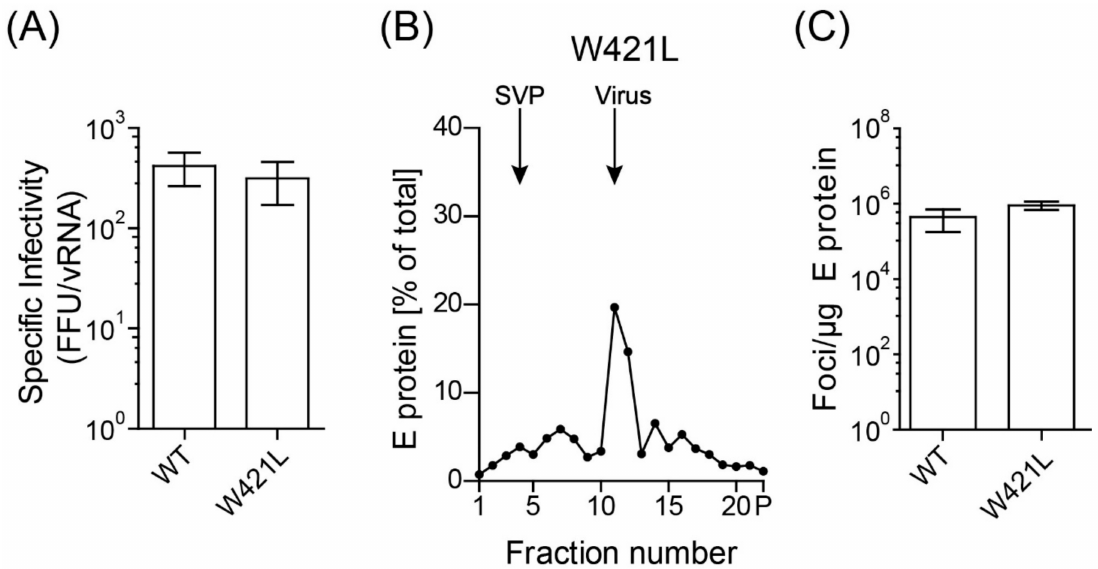
Figure 7. Infectious properties and particle state of W421L mutant. ( A ) Specific infectivities are indicated as number of focus forming units (FFU) per 10E7 RNA copies. ( B ) Resuspended pellets (Figure S4E) containing viral as well as subviral particles (SVPs) were subjected to sedimentation analysis using continuous sucrose gradients. The amount of E protein in each fraction was determined by ELISA. Sedimentation is from left to right. ( C ) Infectivities of virus peak fractions were determined in four independent focus assays and are expressed as number of focus forming units (FFU) per µ g E protein. Data are from at least three independent experiments with mean values and error bars shown in red. Error bars represent the standard errors of the means (SEM). No significant difference to WT was observed ( t